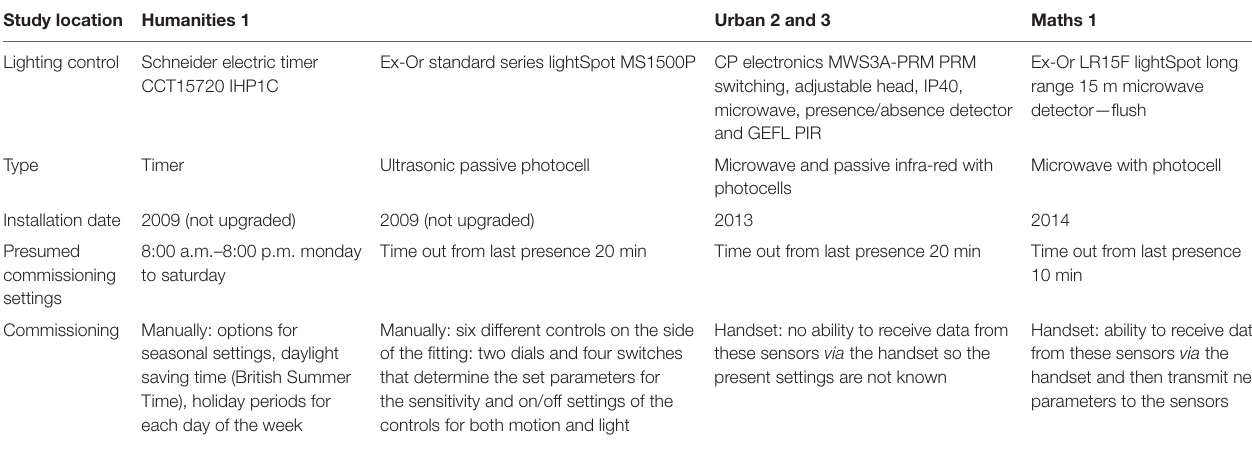
TaBle 1 | Lighting corridor controls field